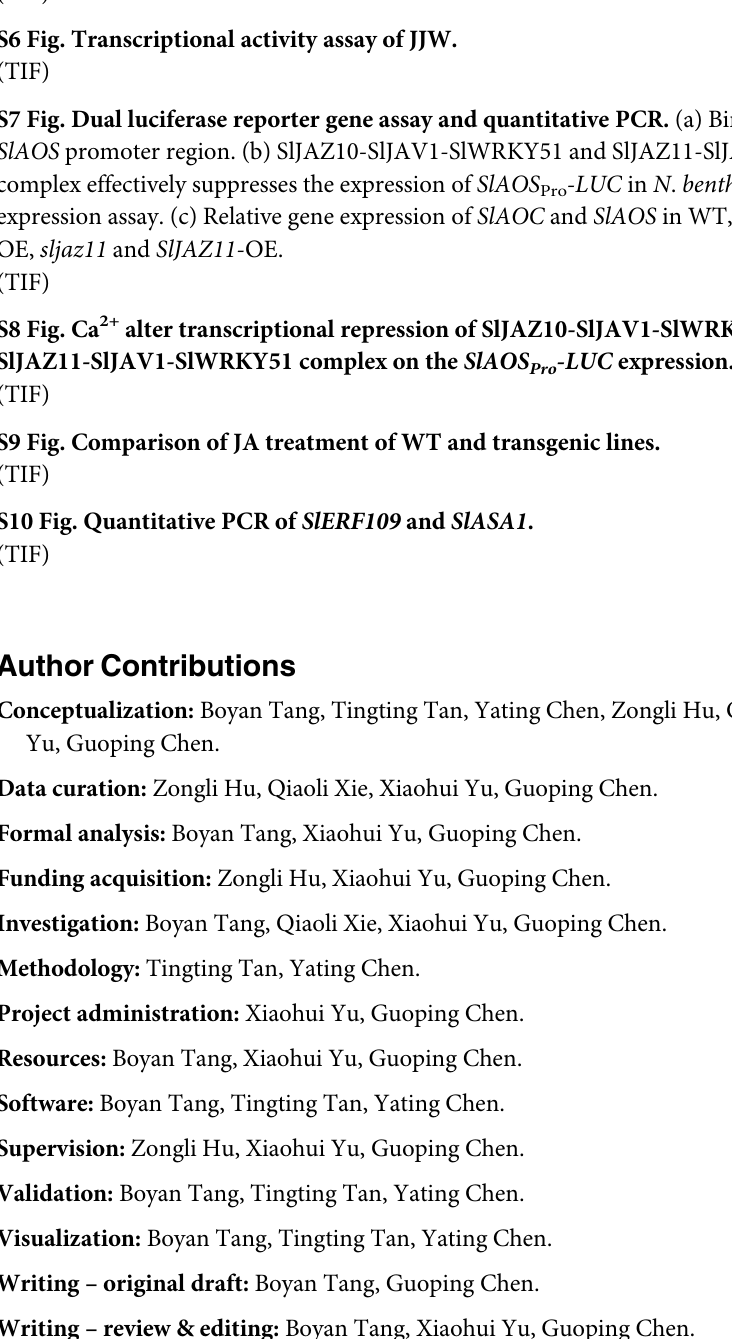
in N . benthamiana transient Pro -LUC